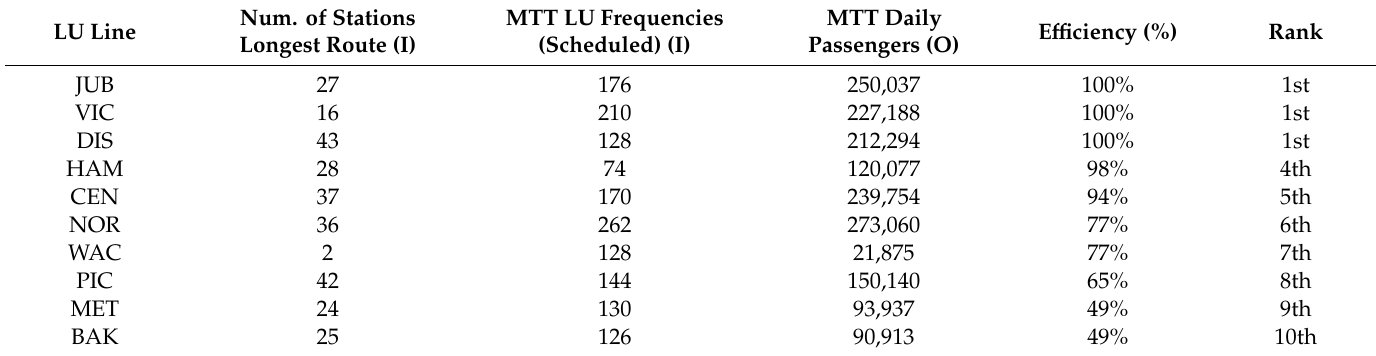
Table 11. URT lines DEA model scores of LU Monday to Thursday (MTT) AM peak tra ffi